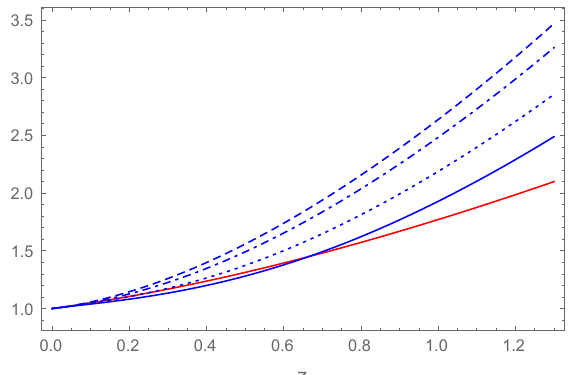
Figure 4. Variation of the dimensionless Hubble function h as a function of z for K µν = + γ ( β ) T µν with different values of the parameters b 3 R 3 T curve), b 3 = 0.08 and g 3 = 0.097 (dotted curve), b 3 = 0.15 and g 3 = 0.30 (dashed curve), and b 3 = 0.21 and g 3 = 0.12 (dot-dashed curve). The evolution of the Hubble function in the standard Λ CDM model is described by the red solid curve.